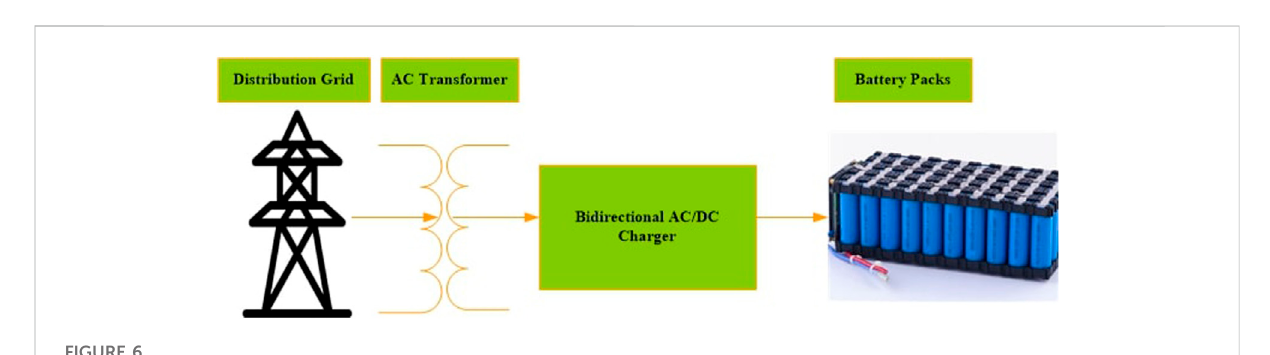
FIGURE 6 Battery swaping